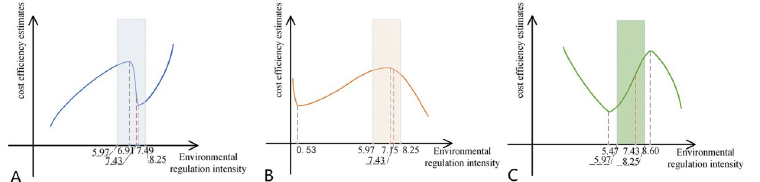
Fig 4. Nonlinear relationship between environmental regulation intensity and cost efficiency estimates. A) the relationship between environmental regulation intensity and cost efficiency of fattening pigs; B) the relationship between environmental regulation intensity and cost efficiency of sows; C) the relationship between environmental regulation intensity and cost efficiency of piglets. A)-C) is only a rough figure representing the relationship between environmental regulation intensity and cost efficiency and is not an accurate functional relationship figure. A)-C) can only reflect the promotion or inhibition of environmental regulation intensity on cost efficiency, and provide an inflection point for the analysis of the paper.